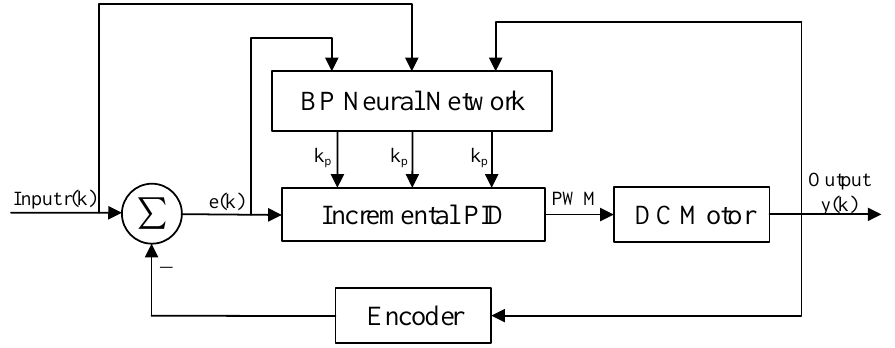
Figure 1. Structure diagram of PID controller system based on BP neural